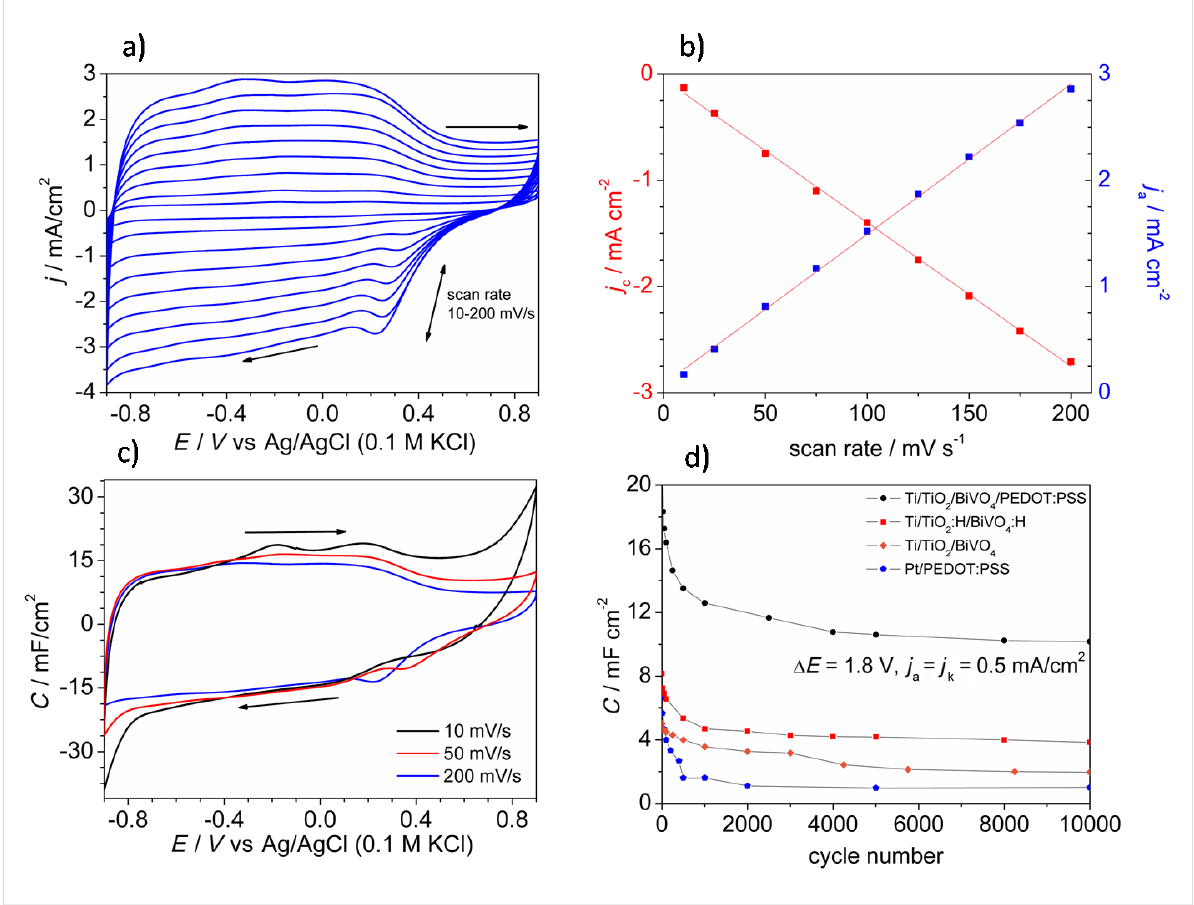
Figure 5: a) The cyclic voltammetry curves of Ti/TiO 2 /BiVO 4 /PEDOT:PSS recorded with various scan rates (10–200 mV·s − 1 ). b) Dependence of cur- rent density at E = 0 V on the scan rate. c) Capacitance as a function of the potential calculated from cv curves. d) Capacitance as a function of the number of cycles resulting from chronopotentiometric